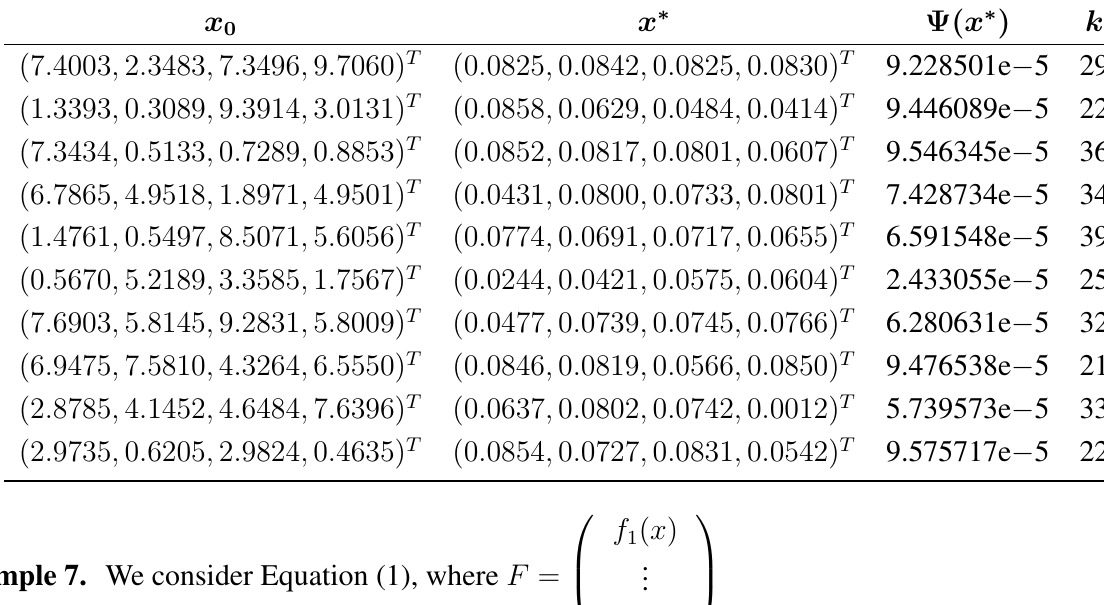
Table 6. Number of iterations and the final value of Ψ( x ∗ )